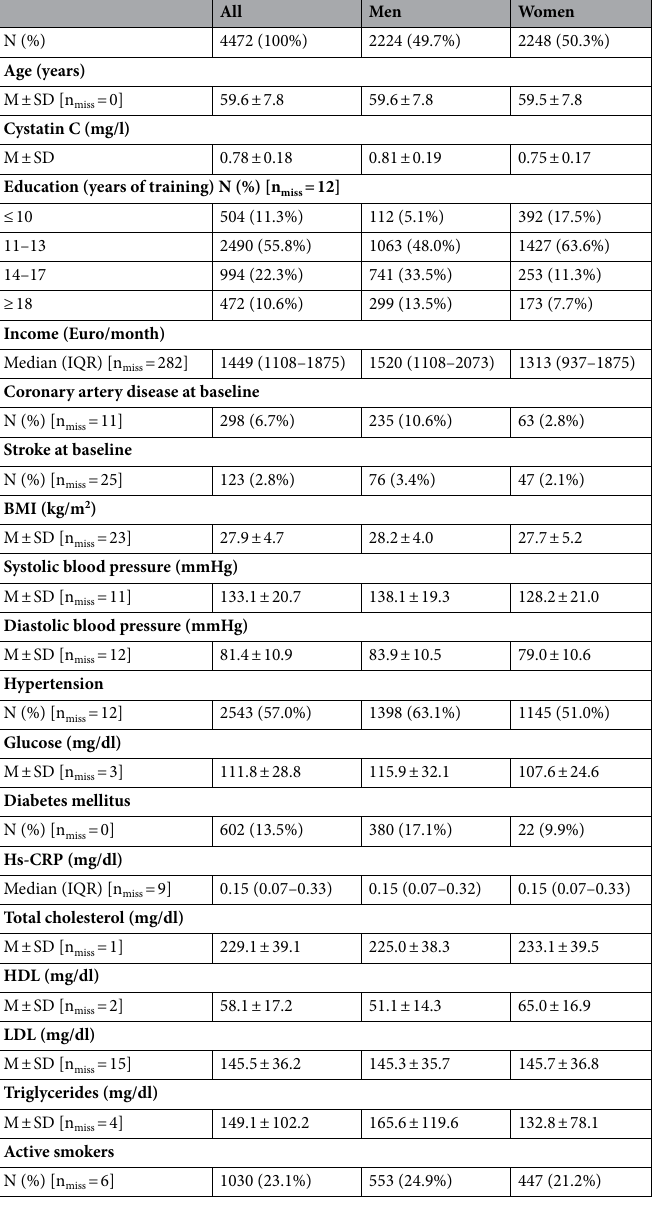
Table 1. Characteristics of the analysis population (M: mean; SD: standard deviation; IQR: interquartile range; [n miss = number of